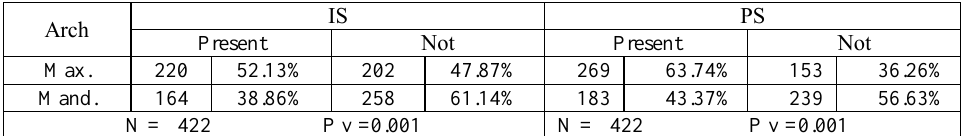
Table 3: differences in the presence of IS and PS between arches